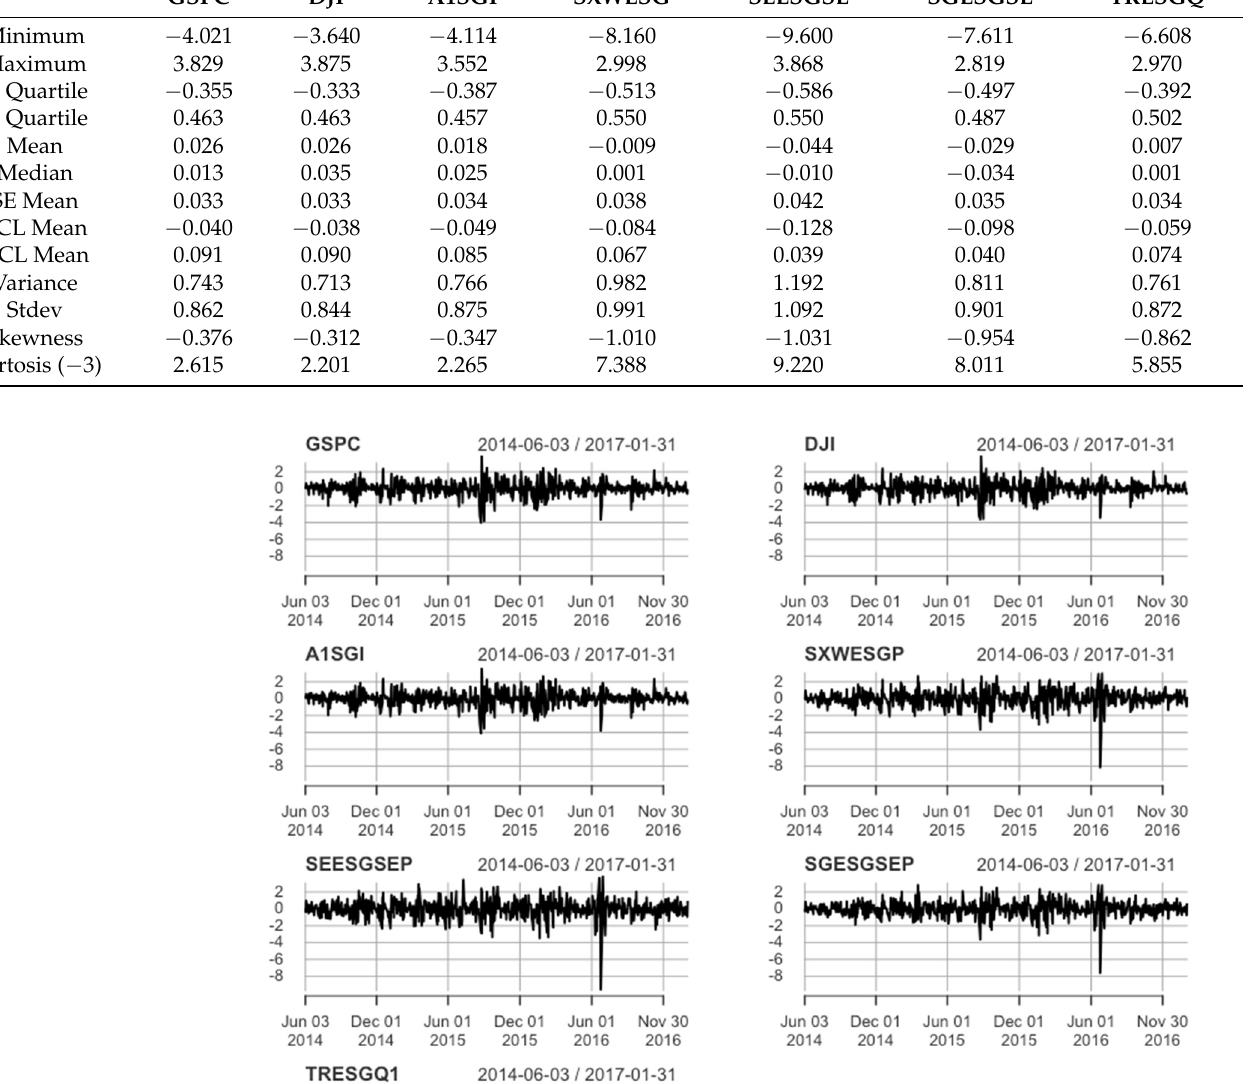
Figure 6. Kendall’s τ and copulas, 3 June 2014–31 January 2017. The dependences between the S&P 500 and ESG indices and between the DJI and ESG indices were modeled by the Clayton–Gumbel and t copulas (see Tables 8 and 9). The dependence between S&P 500 and A1SGI compared to the DJI dependence was modeled differently. For example, the GSPC–A1SGI relationship is modeled by Student’s t copula, and DJI–GESGSEP by Clayton–Gumbel copula.